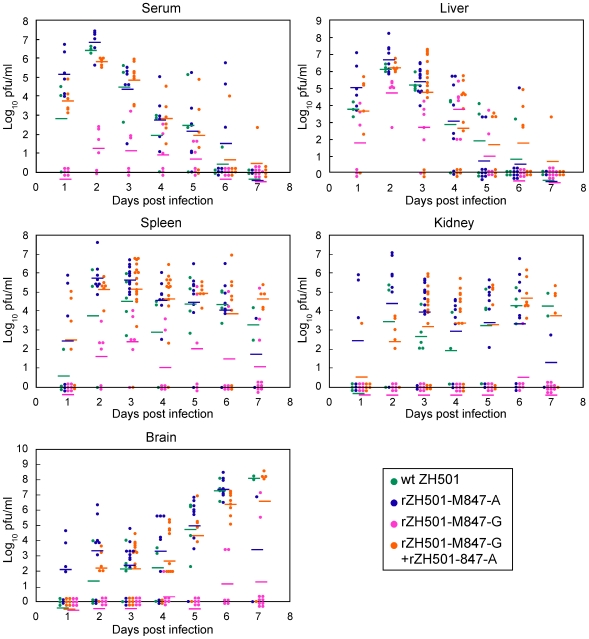
Virus titers in the various organs and serum of infected mice.Five-week-old, female CD-1 mice were inoculated i.p. with 105 PFU of ZH501, rZH501-M847-A, rZH501-M847-G or a mixture of rZH501-M847-A and rZH501-M847-G. At 1 through 7 days p.i., serum, liver, spleen, kidney and brain were collected from infected mice, and virus titers were individually determined by plaque assay. Two to sixteen mice were used for each time point. In some cases, samples were collected from dead mice. They were: ZH501-infected mice–2 at day 3 p.i., 1 at 5 day p.i. and 1 at day 6 p.i.; rZH501-M847-G-infected mice–1 at day 7 p.i.; rZH501-M847-A-infected mice–2 at days 2 and 4 p.i., 5 at day 3 p.i., 3 at day 5 p.i., and 4 at day 6 p.i.; and rZH501-M847-G/rZH501-M847-A-co-infected mice–8 at day 3 p.i., 7 at day 6 p.i., and 2 at day 6 p.i.